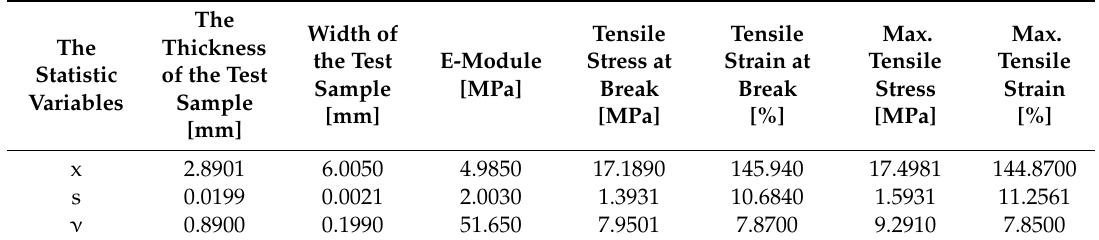
Table 6. Tensile test results according to DIN EN ISO 527 after exposure to laboratory light